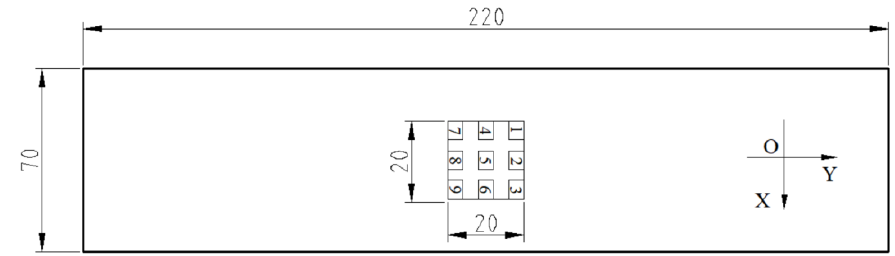
Table 1. Chemical composition (wt.%) and mechanical properties of Q195 steel.